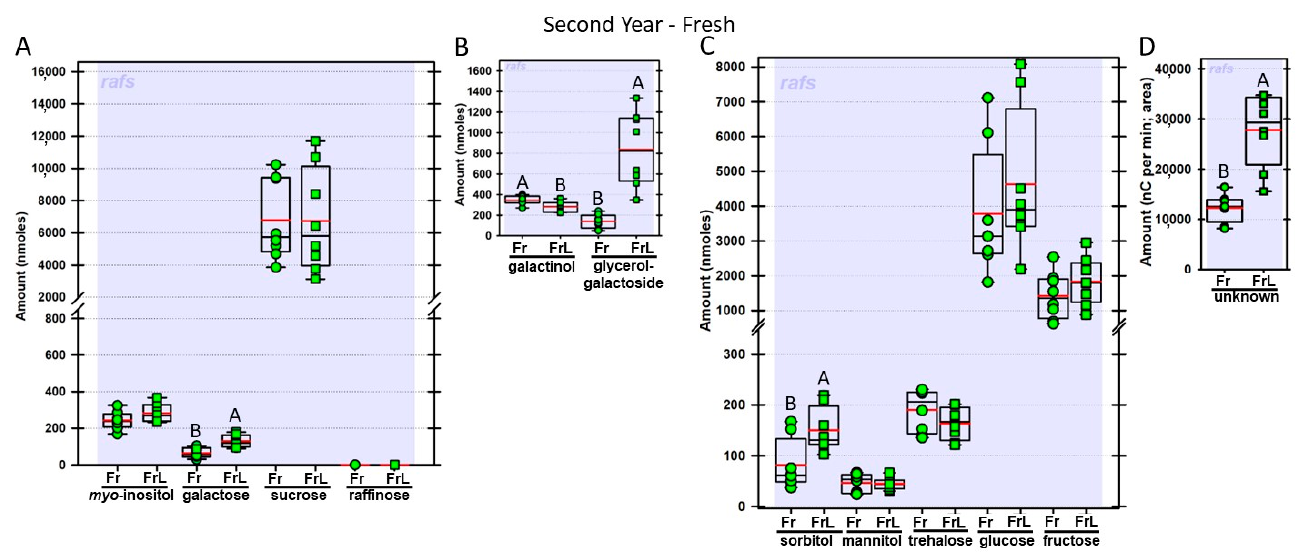
Figure 10. Carbohydrates were analyzed from raffinose synthase mutant ( rafs ) maize leaves. The disks were ground immediately upon harvest (Fr = fresh; light green circles) or were lyophilized to dryness without prior exposure to LN 2 (FrL = fresh lyophilized; light green squares). The same carbohydrates are depicted, and statistically significant differences are determined in the same manner, as in Figure 4.